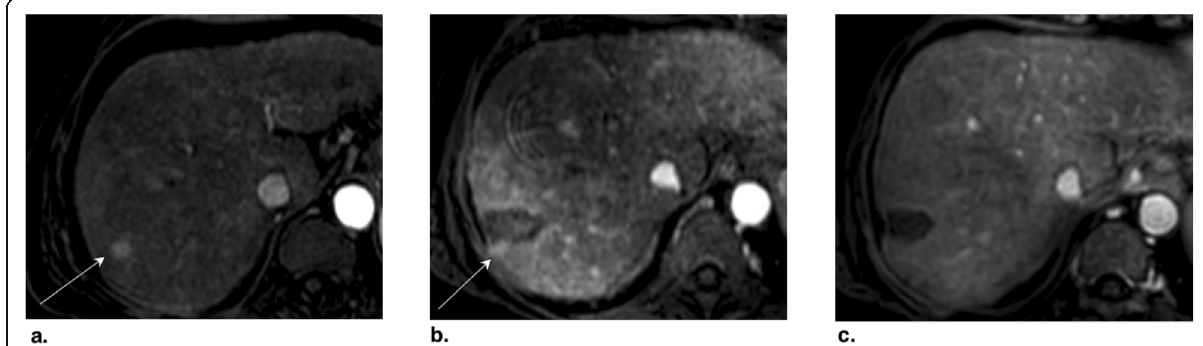
Fig. 12 Axial T1-weighted fat-saturated MR in late arterial phase obtained ( a ) pretreatment: image shows nonrim arterial phase hyperenhancement (APHE) of a small HCC (arrow). b 1 month post radiofrequency ablation (RFA): image shows irregular rim enhancement and more nodular APHE at posterolateral margin (arrow). The treated observation is categorized LR-TR equivocal. c 4 months post RFA: image shows no suspicious enhancement; the treated observation is now categorized LR-TR